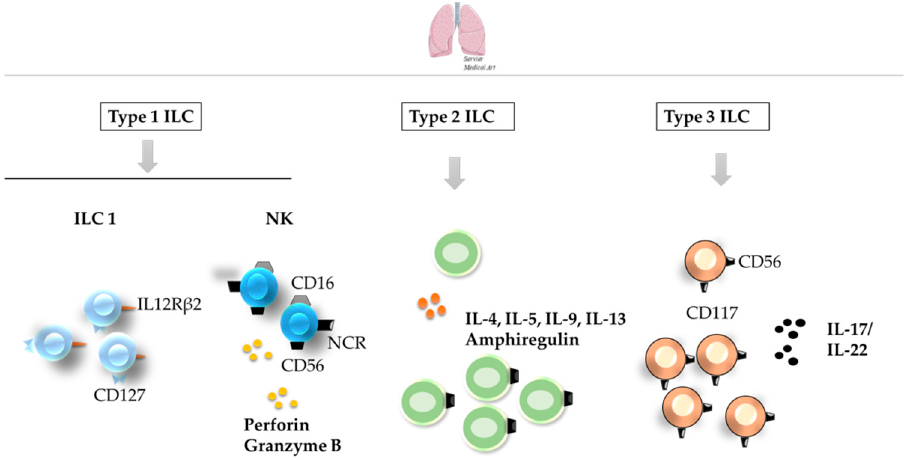
Figure 4. ILCs in the healthy lung. Although ILC1 and NK cells ( left ) can also be found in healthy lung, ILC2s ( middle ) and NCR( − ) ILC3s ( right ) are the predominant subsets in healthy human lungs. Some of the receptors employed for the identification of di ff erent ILC subsets are shown in the image. ILC—innate lymphoid cell; NCR—NK cell